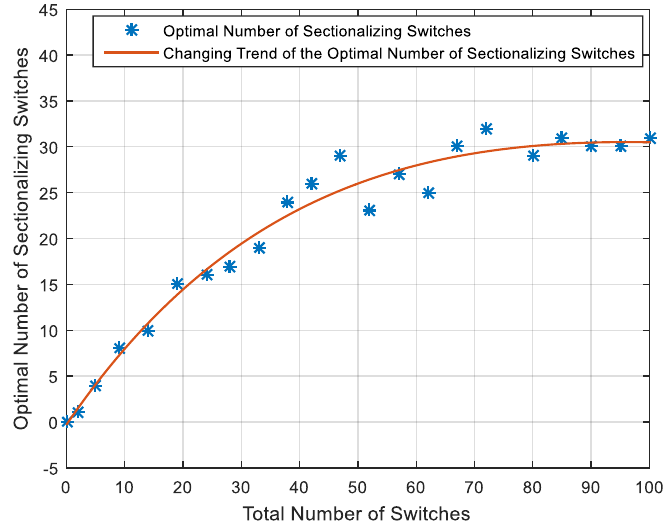
Figure 9. Optimal number of sectionalizing switches corresponding to the maximum system topological flexibility.